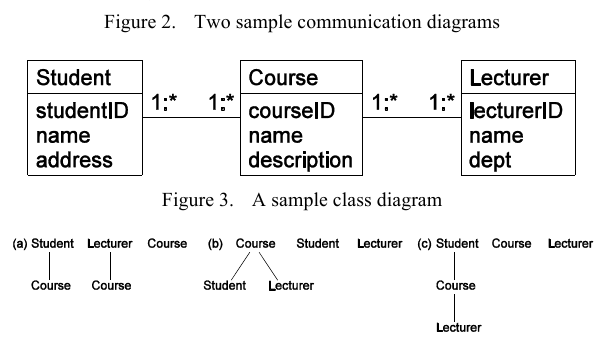
Figure 4. Several possible sets of JSON scheme